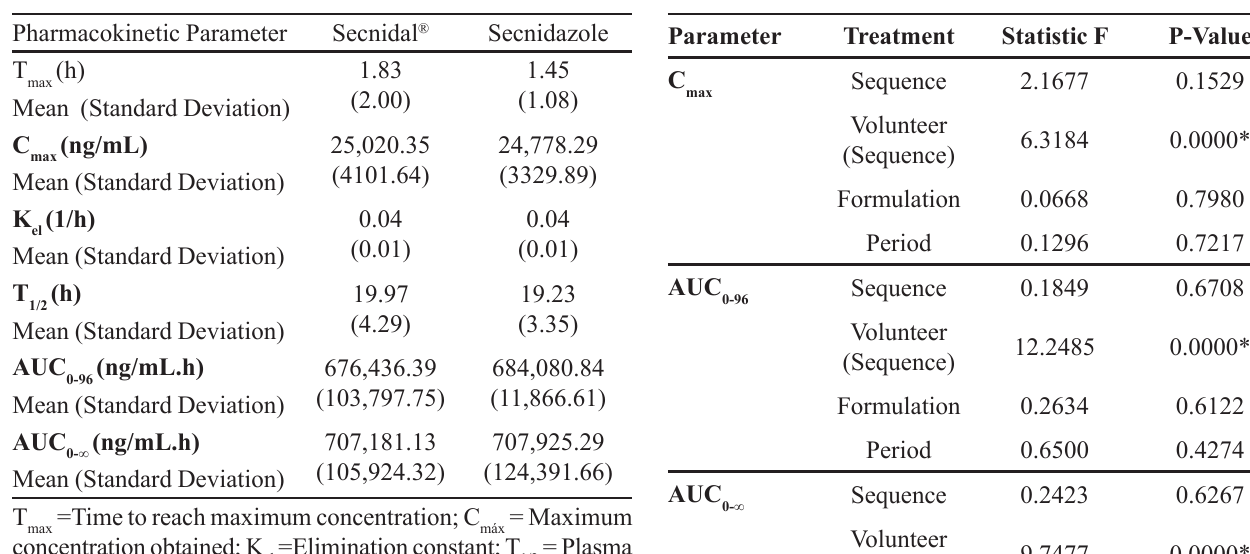
FIGURE 2 - Profile of mean plasma concentrations (± 2 standard errors) of secnidazole versus time, for one dose of the test and reference formulations of an oral dose of secnidazole 1000 mg. TABLE II - Analysis of Variance (ANOVA) of the TABLE 1 - Pharmacologic parameters of the reference standard and test medications